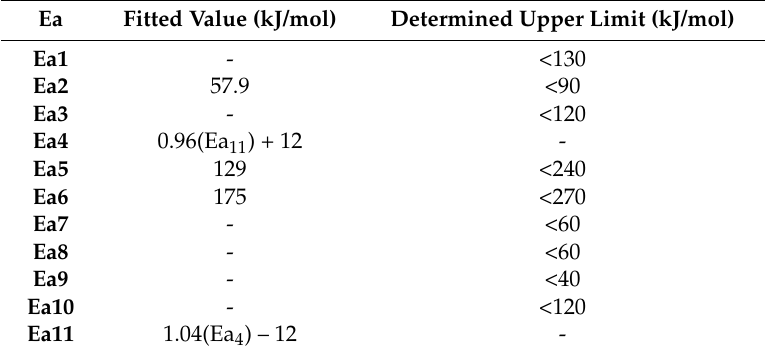
Table 2. Fitted Values and Upper Limits for the Activation Energies (Ea) of Each Reaction, from Microkinetic Model and Experimental Data at 70–100 ◦ C